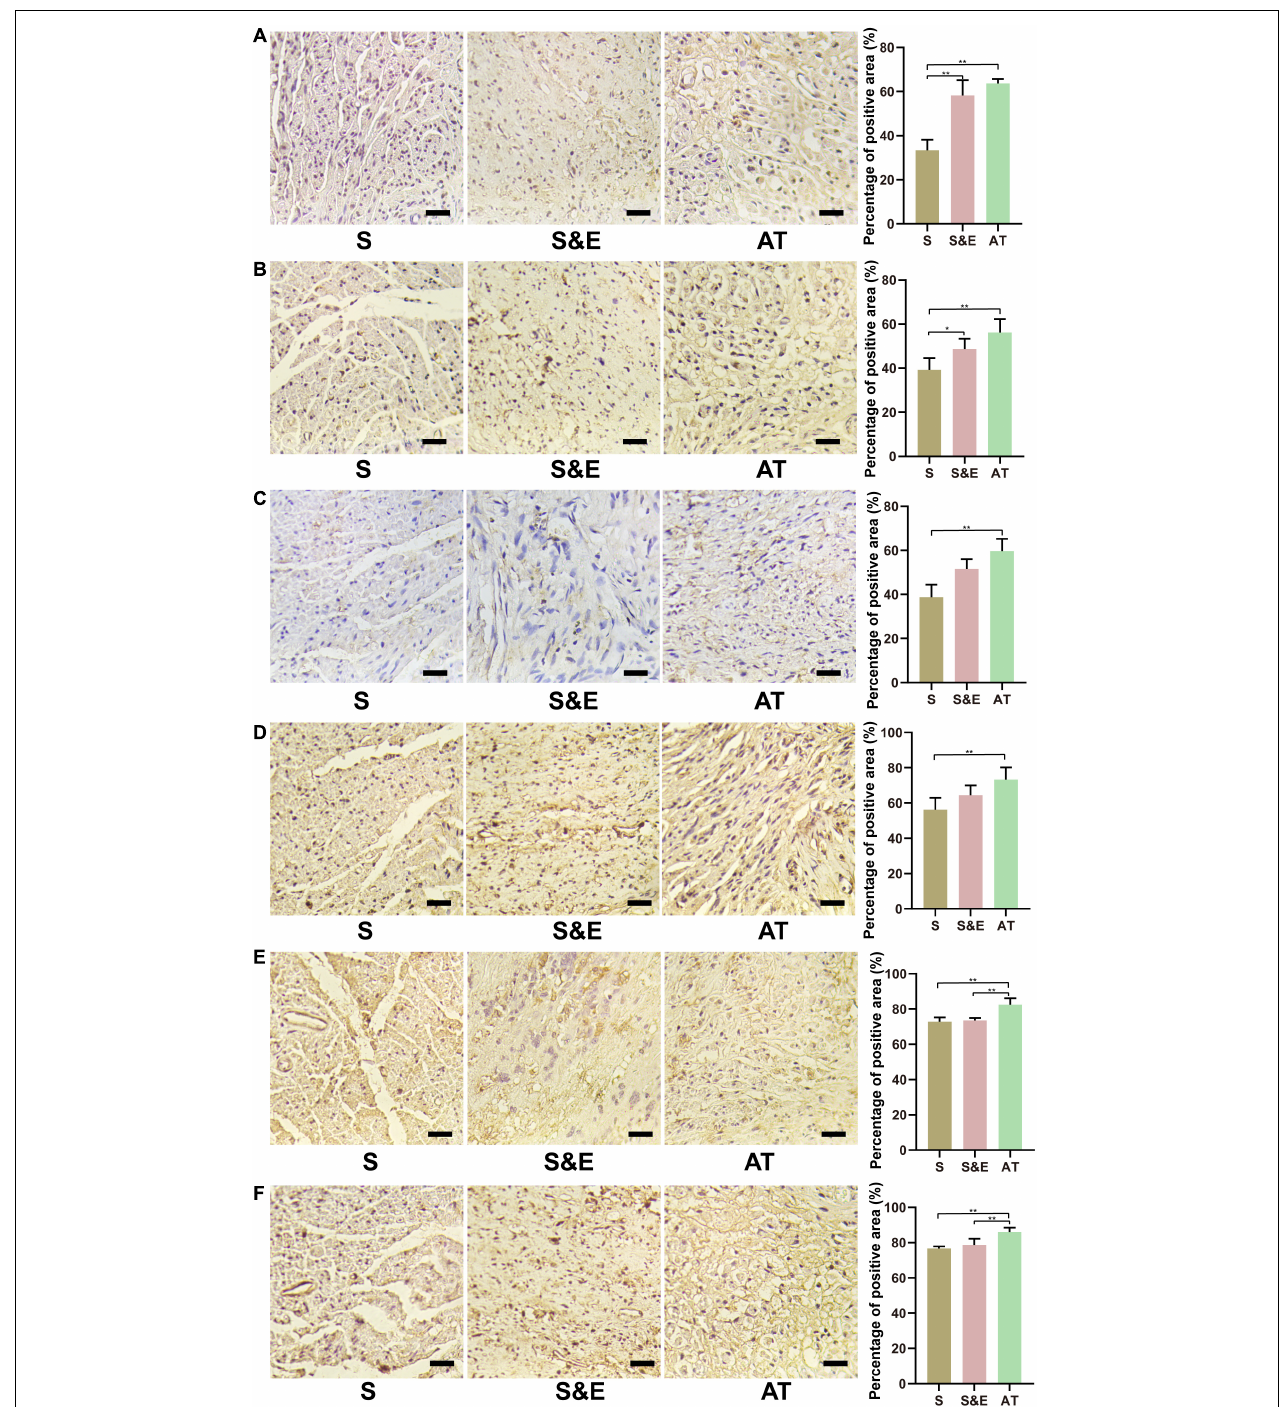
FIGURE 9 | Immunohistochemical staining images and results at 12th week after implantation. (A) NF-H protein. (B) S100- β protein. (C) LRP4 protein. (D) p38 MAPK protein. (E) ERK protein. (F) MEK protein. Scale = 25 µ m. n = 5, * p < 0.05, ** p < 0.01.